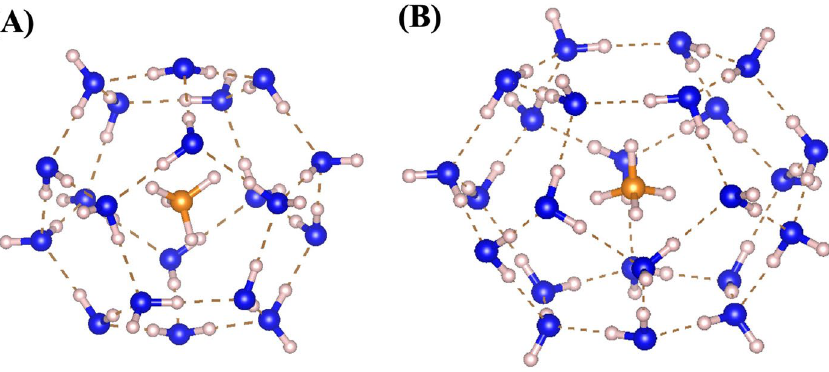
Figure 5. sI methane hydrates have small ( A ) and large ( B ) cages. ( A ) A small cage consists of 12 pentagonal faces and a methane molecule at its center. Large cages ( B ) have 12 pentagonal faces and two hexagonal faces, with a guest methane molecule at the center. Water oxygen atoms are represented by blue circles. Hydrogen atoms are represented by pink-white circles. Carbon atoms are denoted by orange circles. All solid lines represent covalent bonds; their colors indicate which two atoms formed the covalent bond. OH hydrogen bonds are displayed by the brown dashed